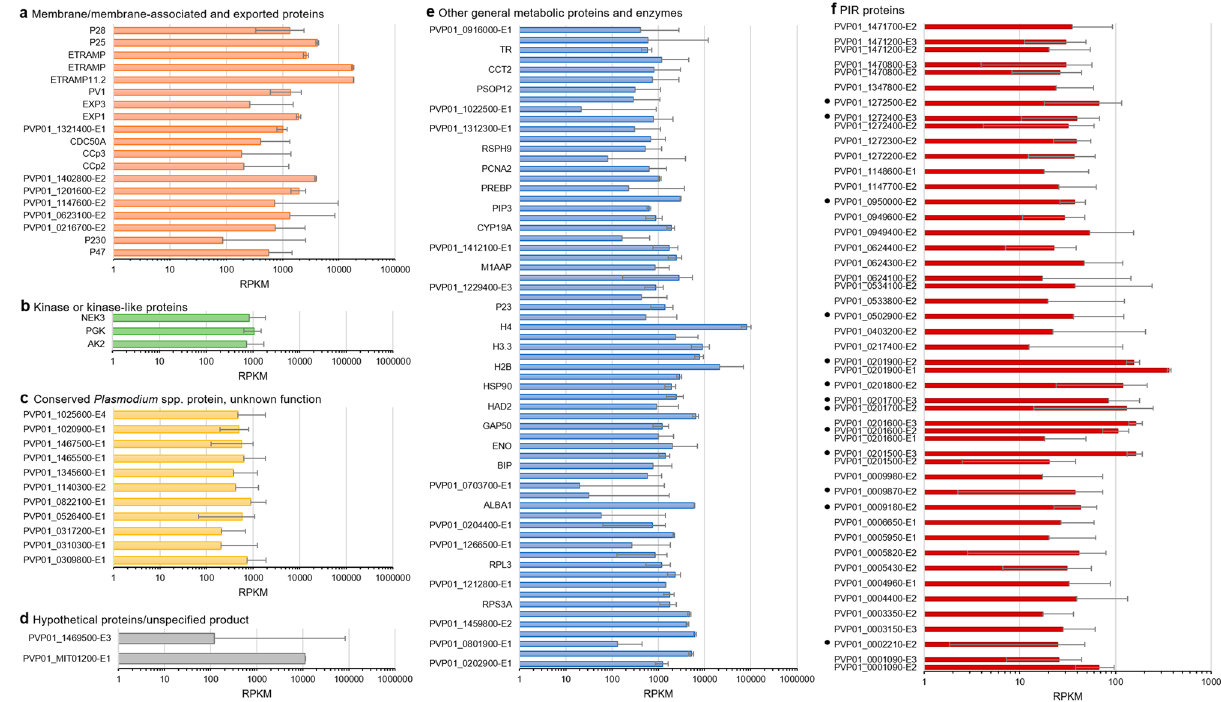
Figure 4. Expression levels of P. vivax transcripts. Expression levels in gene coverage within the four different P. vivax isolates of ( a ) membrane and membrane-associated and exported proteins, ( b ) kinase or kinase-like proteins, ( c ) conserved Plasmodium spp. proteins of unknown function, ( d ) hypothetical proteins and unspecific products, ( e ) other general metabolic proteins and enzymes, and ( f ) PIR proteins. Black dots highlight the pir transcripts expressed across all isolates. Error bars represent the standard deviation between exons RPKM across all samples (Supplementary Table